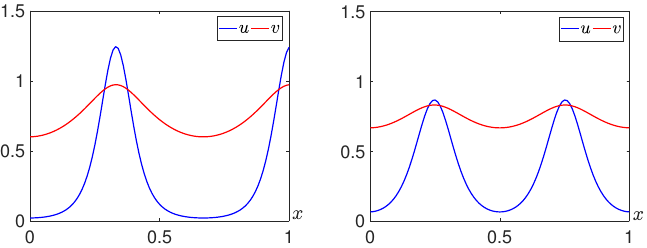
Figure 4. Multistability of Systems (1), (2) with a = d = e = 0.5, b = c = 1, D u = 5 × 10 − 4 , D v = 0.02, and ε = 0: 1.5 ↑ pattern ( left ) and 2 ↑ pattern ( right